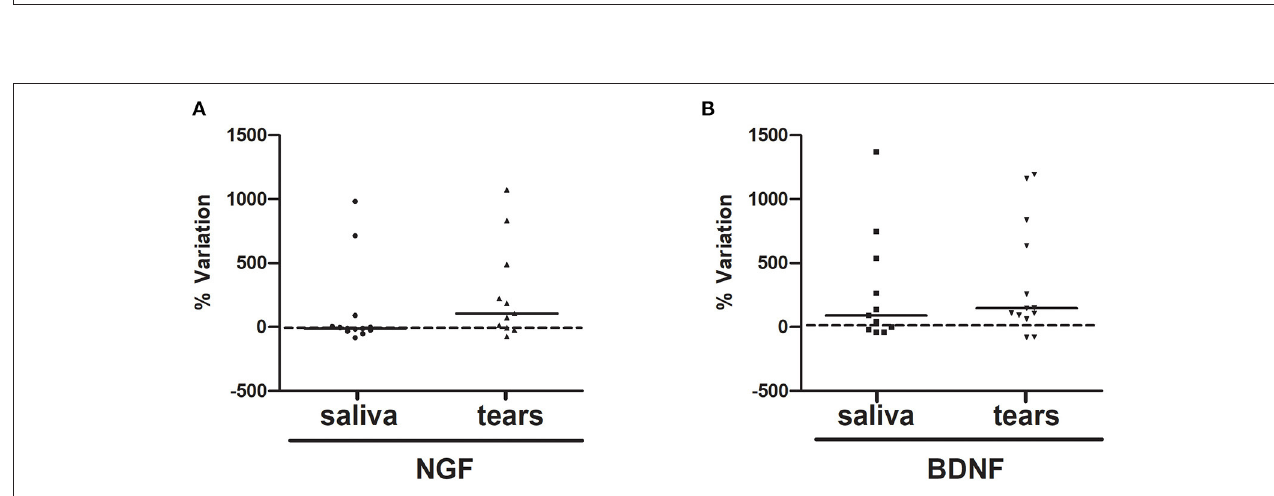
Frontiers in Psychiatry |